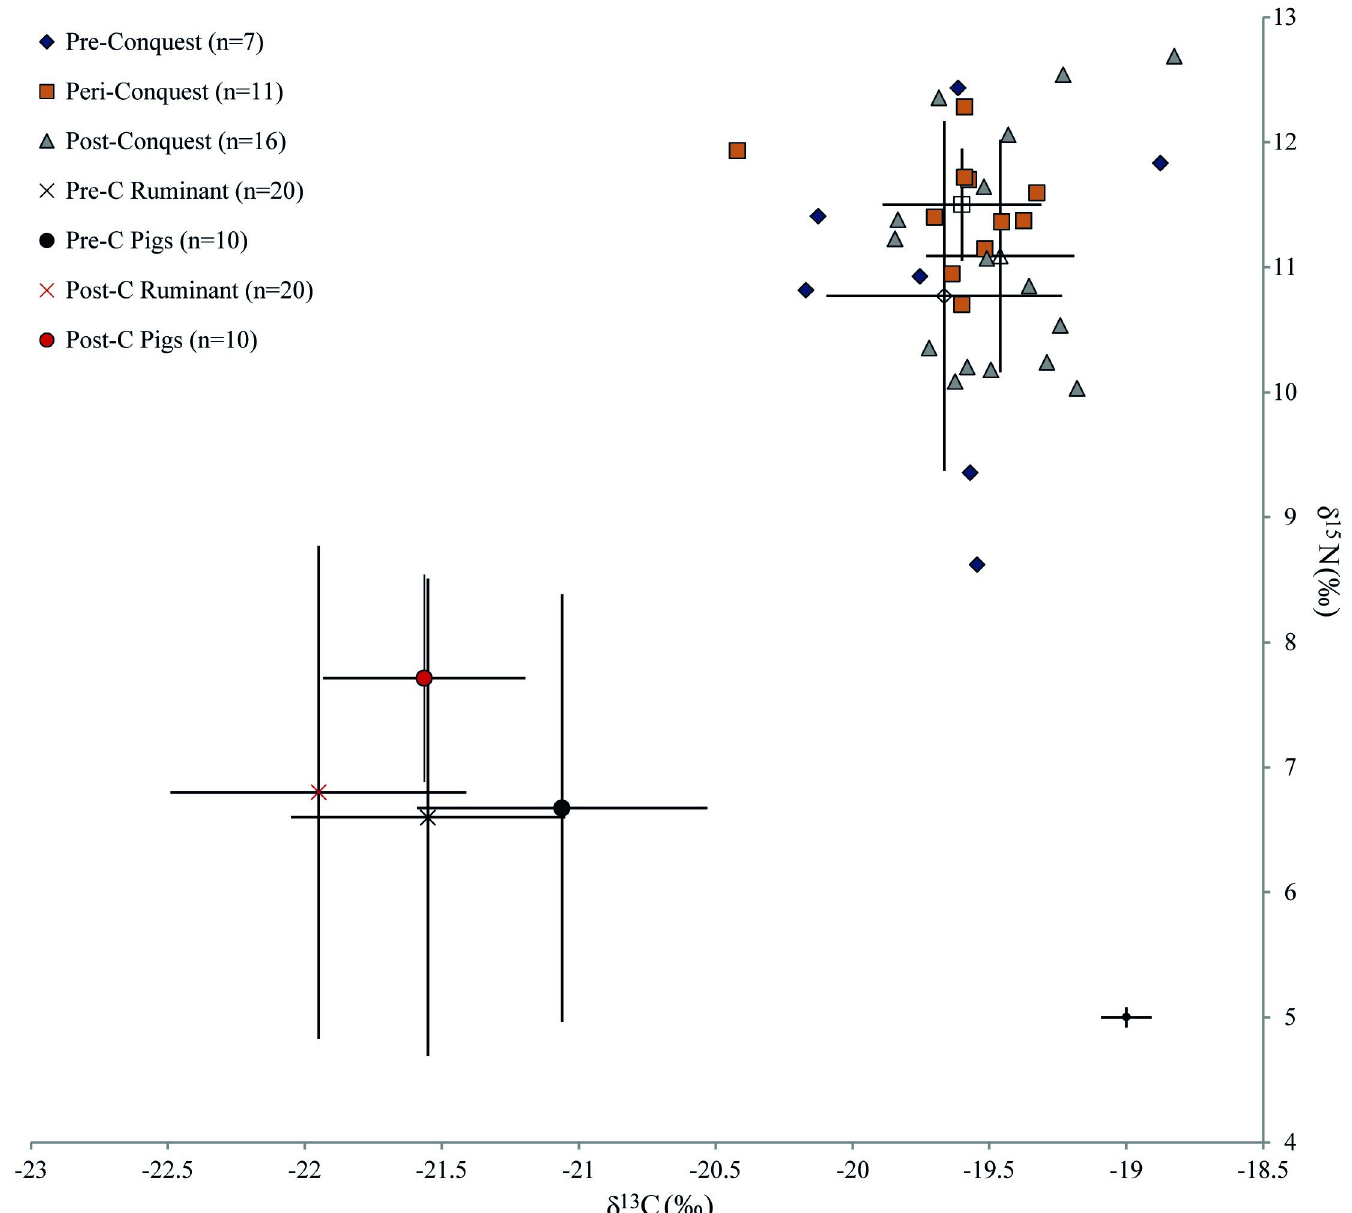
Fig 5. δ 13 C and δ 15 N values from animal and human bone collagen organised by phase. Error bars represent one standard deviation and analytical error is displayed at the bottom right of the